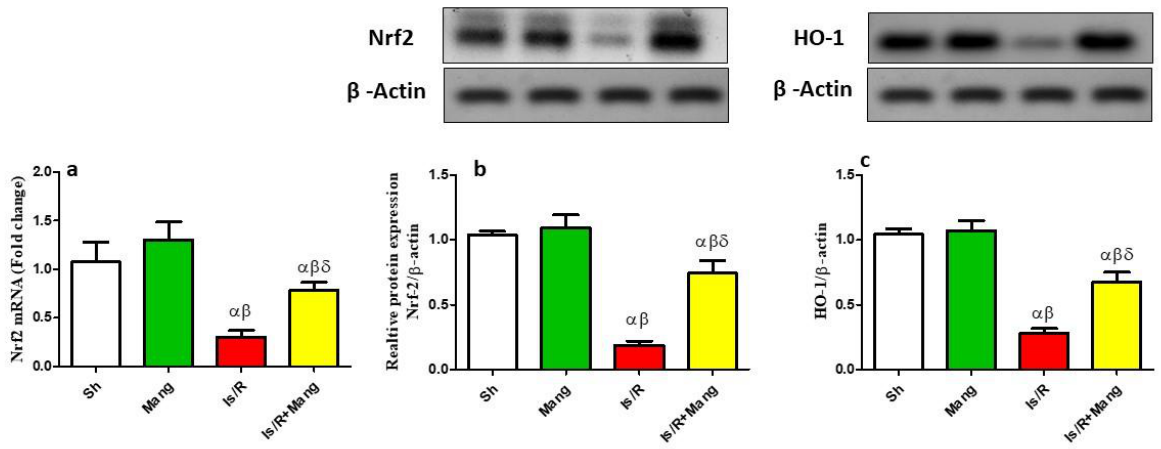
Figure 1. Mang ’s (20 mg/kg, i.p) impact on renal Nrf2 either the ( a ) mRNA or ( b ) protein expression and ( c ) HO-1 protein expression as an antioxidant signaling cue. Data were articulated as the mean ( n = 7) ± SD, p value< 0.05 is significant. As compared with sham (α ), Mang ( β), and Is/R (δ) treated groups.